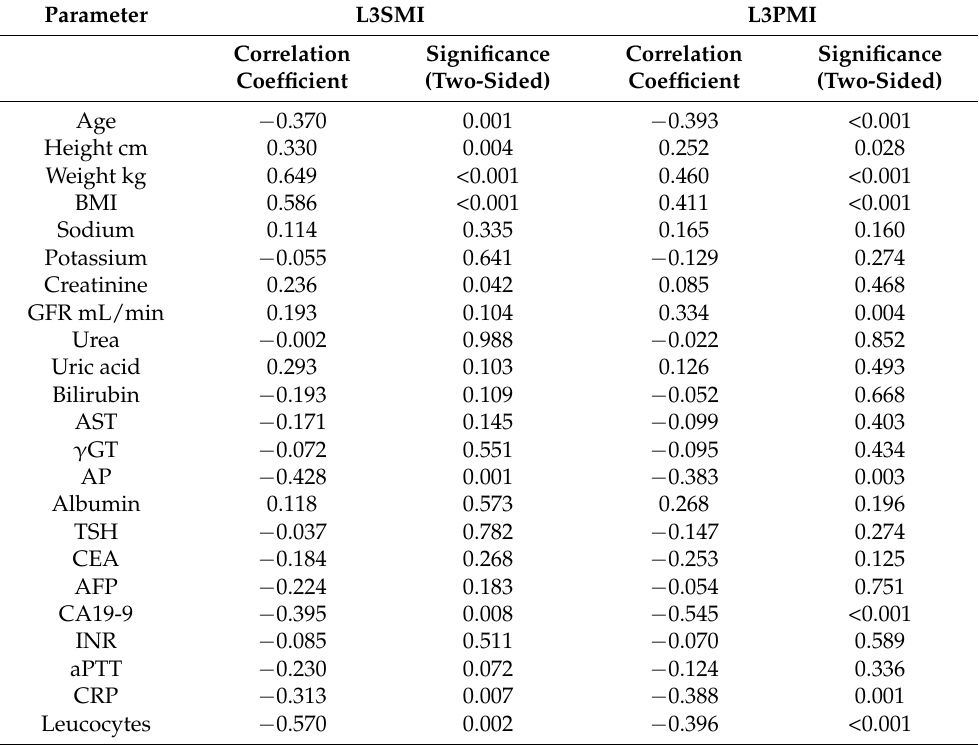
Table 3. Spearman Correlation of L3SMI and L3PMI with relevant